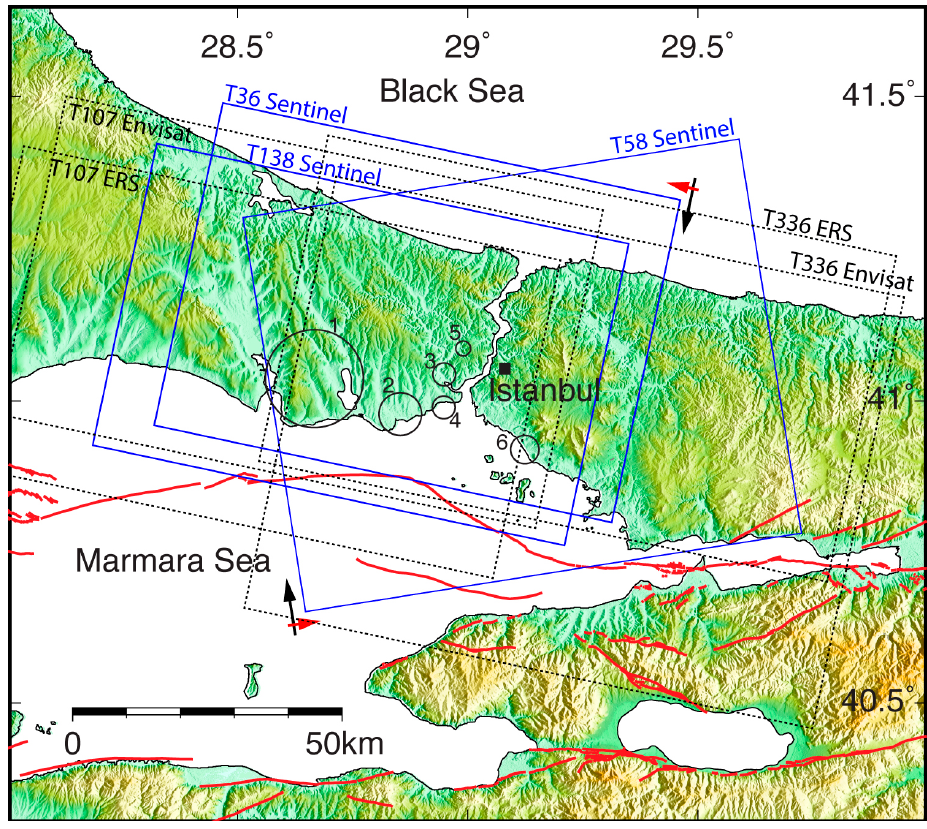
Figure 1. Study area and satellite synthetic aperture radar data coverage used in the present study. The shaded topography is given by the Shuttle Radar Topography Mission (SRTM) along the North Anatolian Fault (NAF) in the Sea of Marmara, and major faults are drawn in red [35]. Rectangles labeled with sensor and track numbers indicate the coverage of the SAR images that were used in the present study. The red and black arrows indicate satellite’s line-of-sight look and flight directions, respectively. Circles with numbers show the study regions in the paper (details are given in the text).